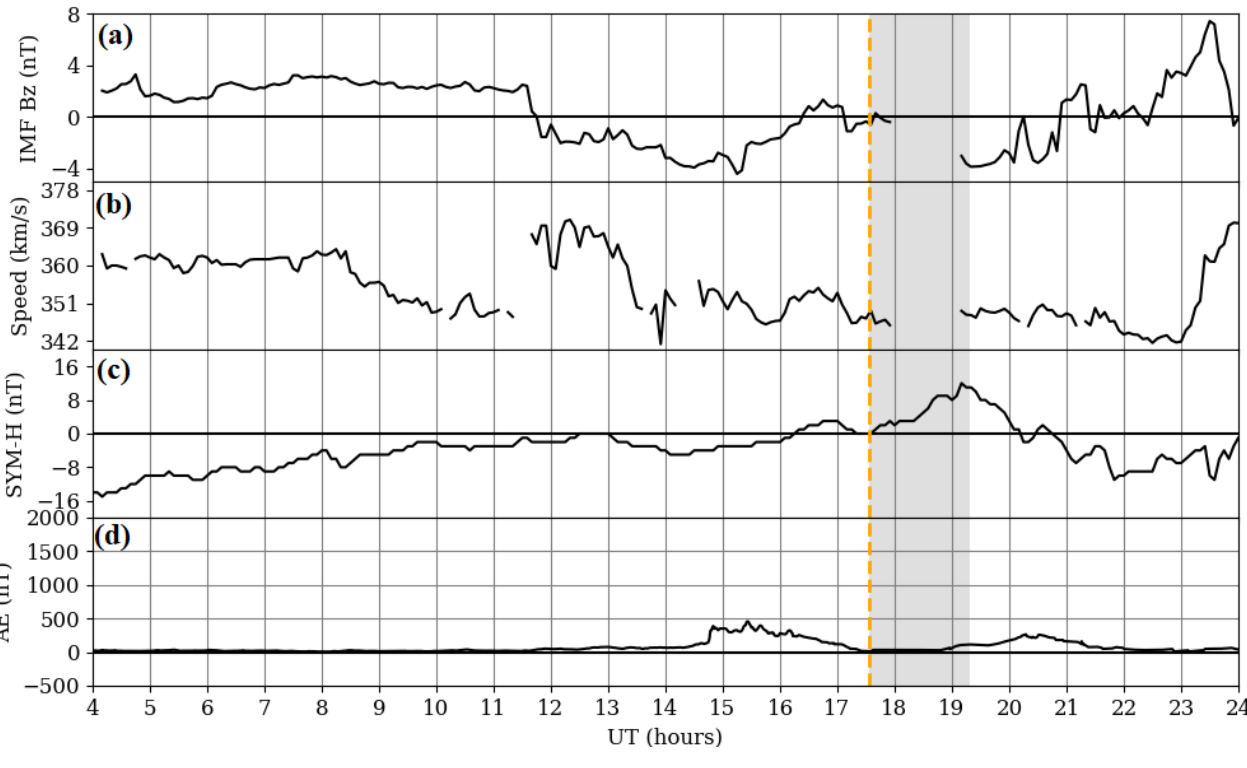
Figure A4. Time series of interplanetary plasma parameters and geomagnetic indices for the day of the earthquake: ( a ) the north–south (Bz) component in GSM coordinates; ( b ) solar wind speed; ( c ) SYM-H index; ( d ) auroral electrojet index. Bz, solar wind speed and SYM-H data are available at OMNIWeb https://omniweb.gsfc.nasa.gov/ (accessed on 5 November 2021). The vertical dashed orange lines indicate the onset time of the mainshock of Mw